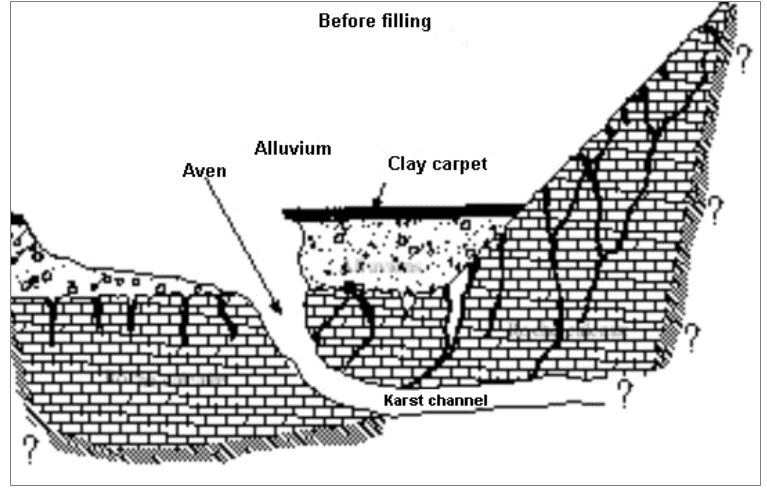
Figure 24. Diagram of a longitudinal section of the vortex n°2 before its sealing